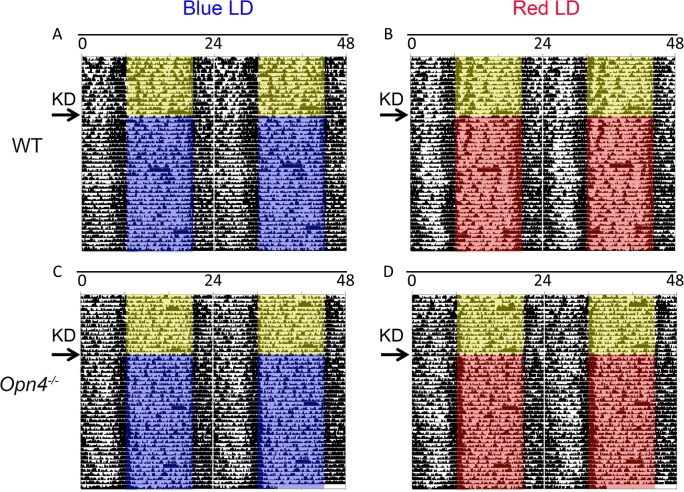
Both Opn4
-/- mice and the wild type controls entrain to a 12h:12h fluorescent LD cycle (yellow block corresponds to fluorescent lights on) as measured by radio-telemetry.After two weeks, animals are transferred to a 12h:12h blue or red LD cycle (red and blue blocks corresponds to lights on) and concurrently placed on a KD. A and B) Representative actograms of WT animals. C and D) Representative actograms of Opn4
-/- animals. Arrows indicate the day animals are switched to the KD. All actograms have been double-plotted with a 10-minute bin size. (Under red LD cycle: Opn4
-/- n = 4, WT n = 5. Under blue LD cycle: Opn4
-/- n = 4, WT n = 4.)